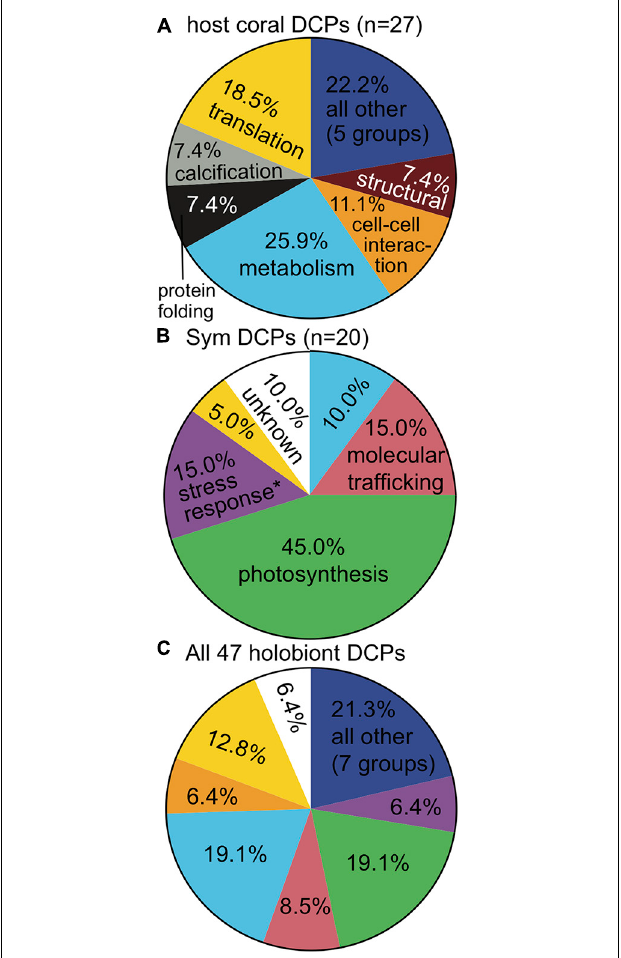
FIGURE 2 | Functional breakdown of differentially concentrated proteins (DCPs). The cellular process color codes are shown only the first time they are used (the exception being the “all other” category). When proteins involved in a cellular process (e.g., stress response) were documented at a significantly higher proportion in one compartment vs. the other (Fisher’s exact test, p < 0.01), the process name in the compartment with the higher value has been denoted by an asterisk ( ∗ ). Processes specific to anthozoan hosts (A) (i.e., calcification) and dinoflagellates (B) (i.e., photosynthesis) were excluded from this